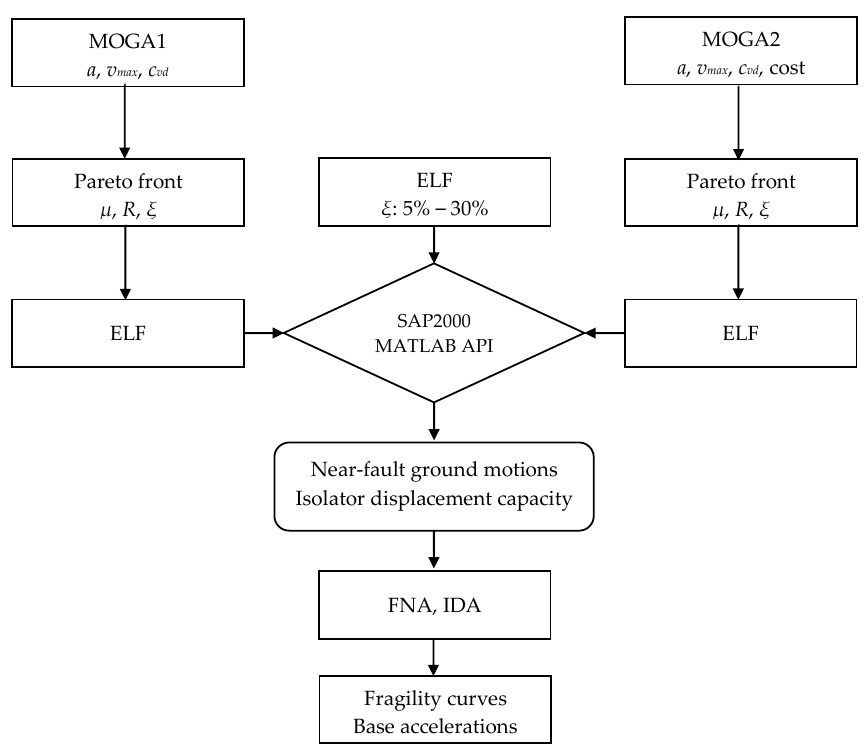
Figure 3. Flowchart of multi-objective optimization and dynamic analyses procedures.